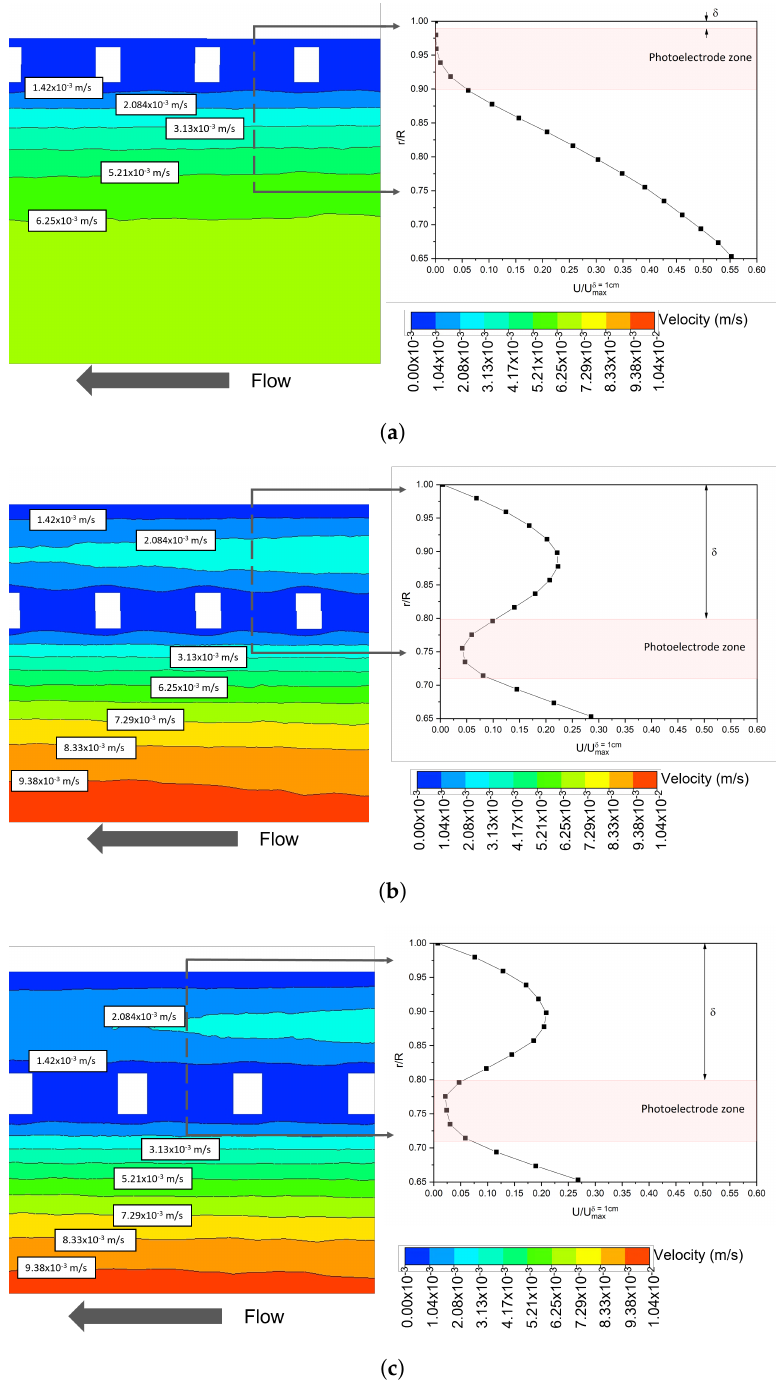
Figure 10. Contour plots and velocity magnitude profiles in laminar regime with w constant (0.6 cm) and δ equal to ( a ) 0.1 cm, ( b ) 1 cm with WME and ( c ) 1 cm with